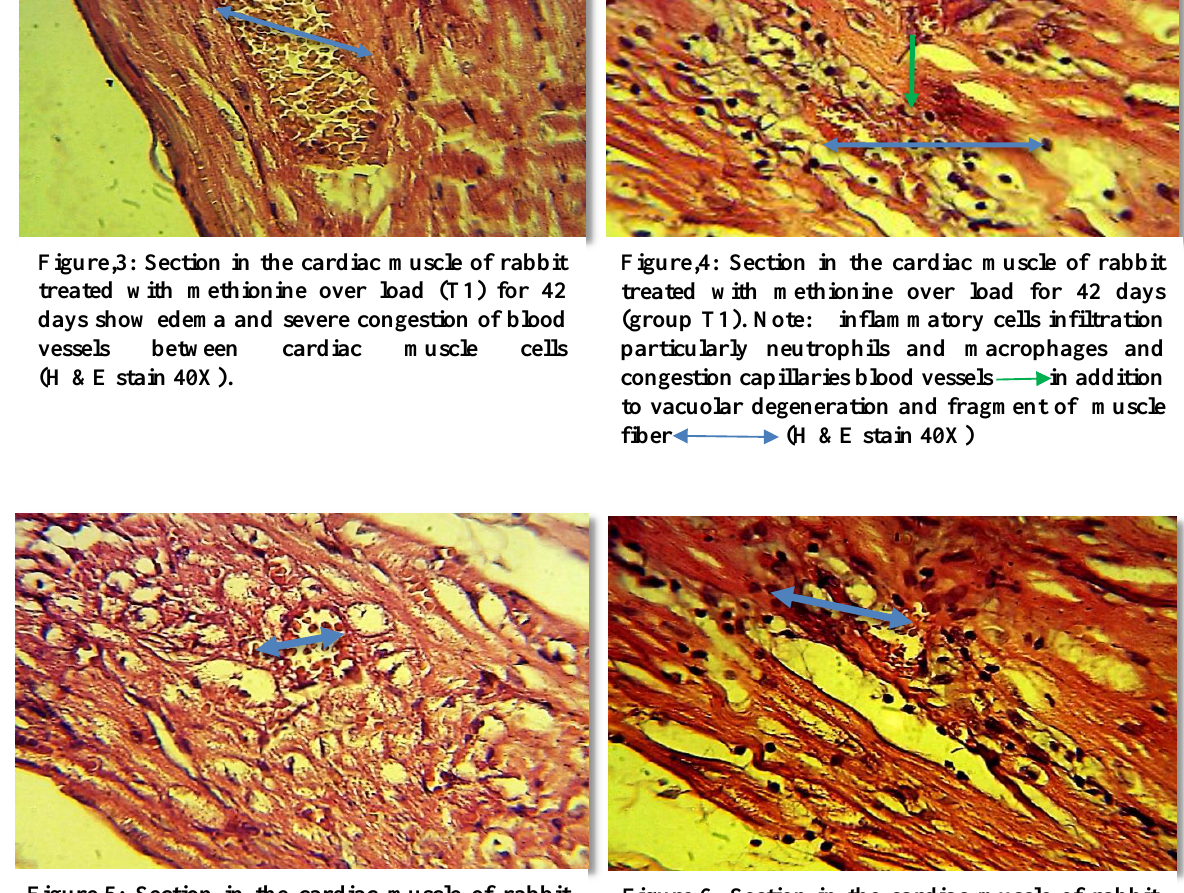
Figure,6: Section in the cardiac muscle of rabbit after 42 day of treatment with methionine over load (group T1). Note: congestion of blood vessels with inflammatory cells infiltration and fragment of muscle fiber (H &E stain